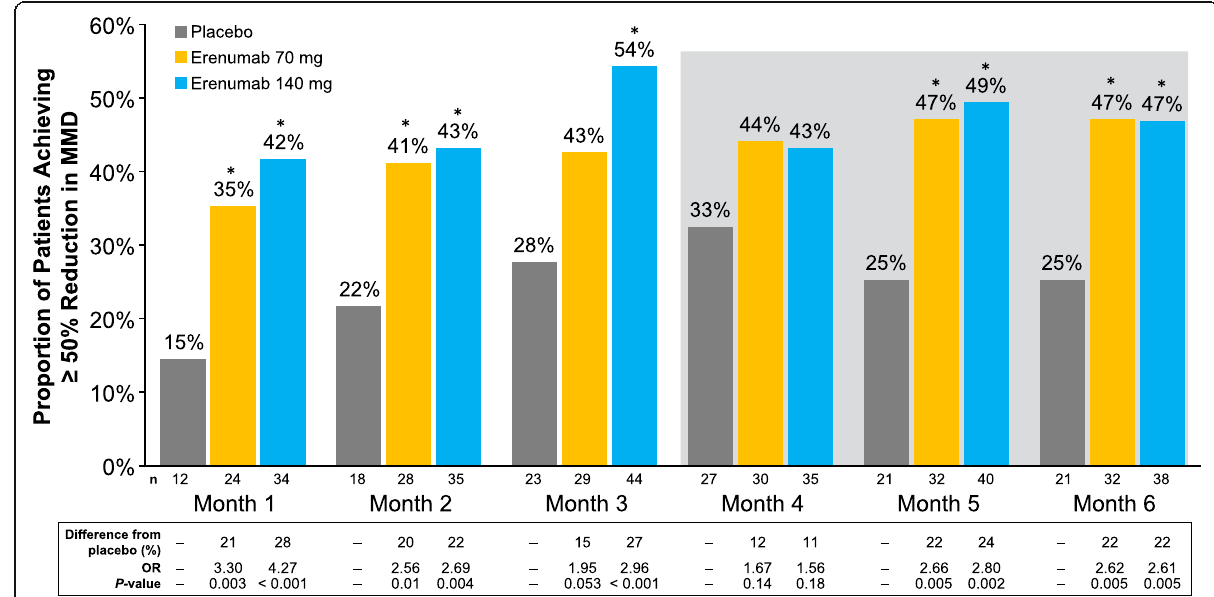
Fig. 3 Proportion of patients achieving ≥ 50% reduction from baseline in MMD. Data are shown as percentages. The gray shaded area represents